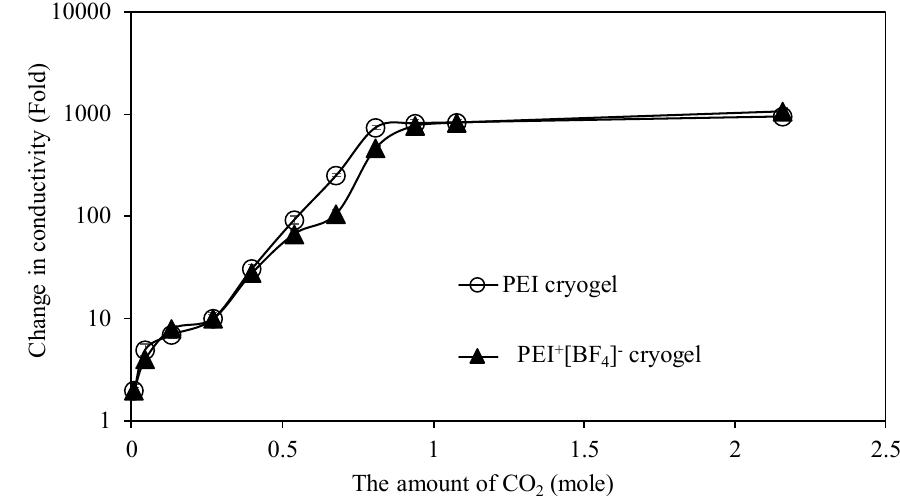
Figure 6. The comparison of sensitivities of bare PEI cryogel and PEI + [BF 4 ] - cryogel under different amounts of CO 2 exposure [200 mL/min flow rate].